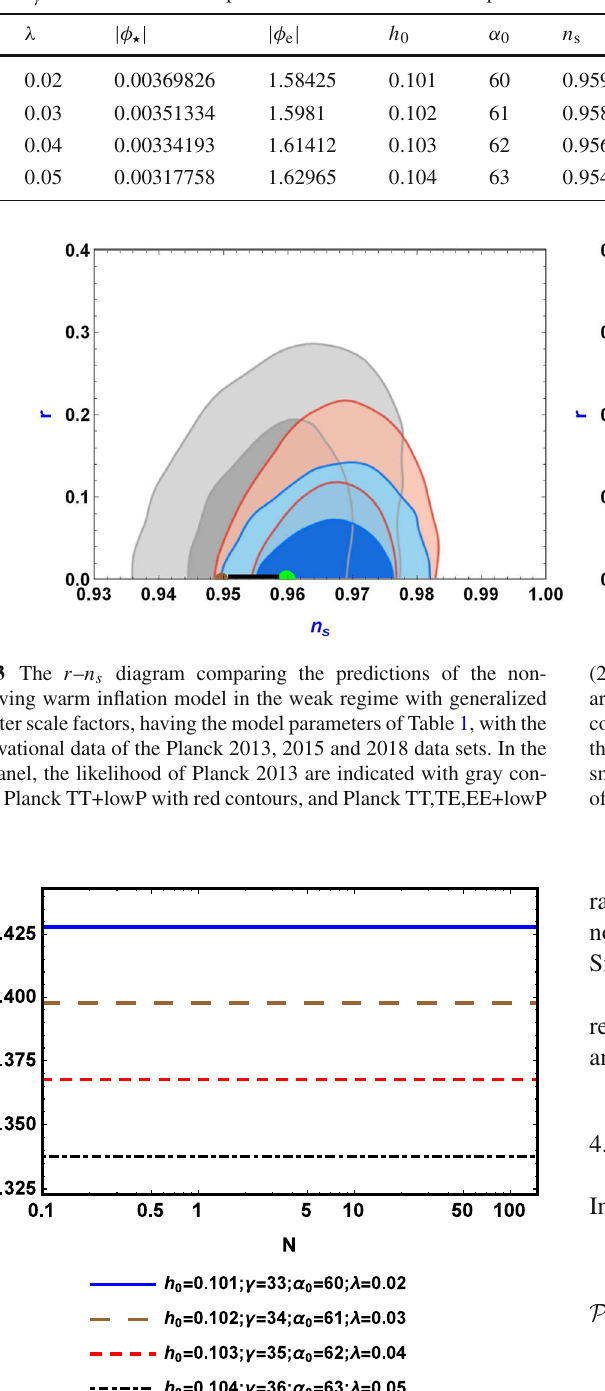
eters we have fixed the power spectrum to its horizon exit value, i.e., P